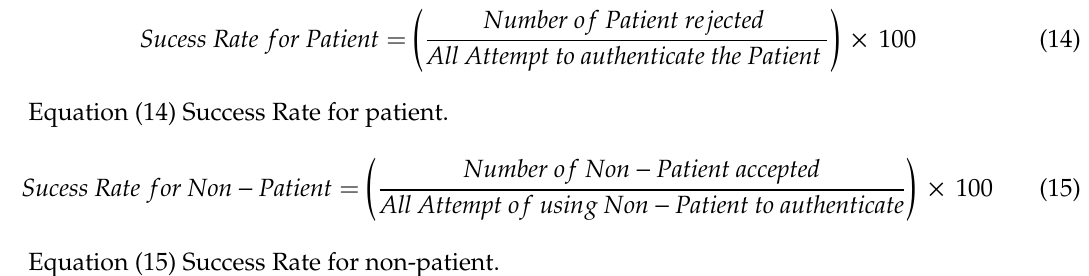
Table 5. Showing authentication evaluation of success rate.